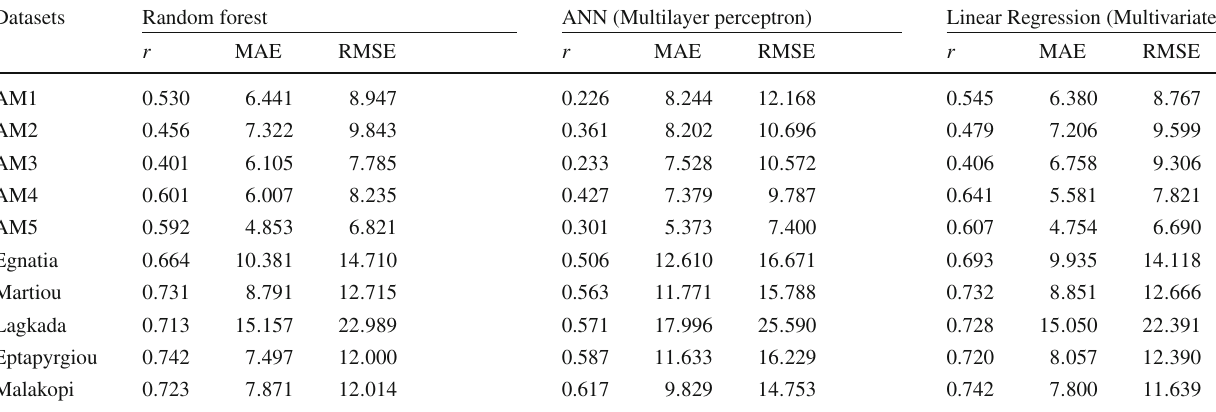
Datasets Random forest ANN (Multilayer perceptron) Linear Regression